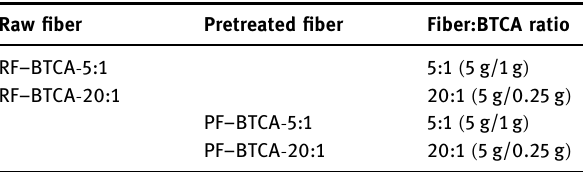
Table 1: Nomenclature and concentrations of the cross - linking agent and catalyst used in this research Raw fi ber Pretreated fi